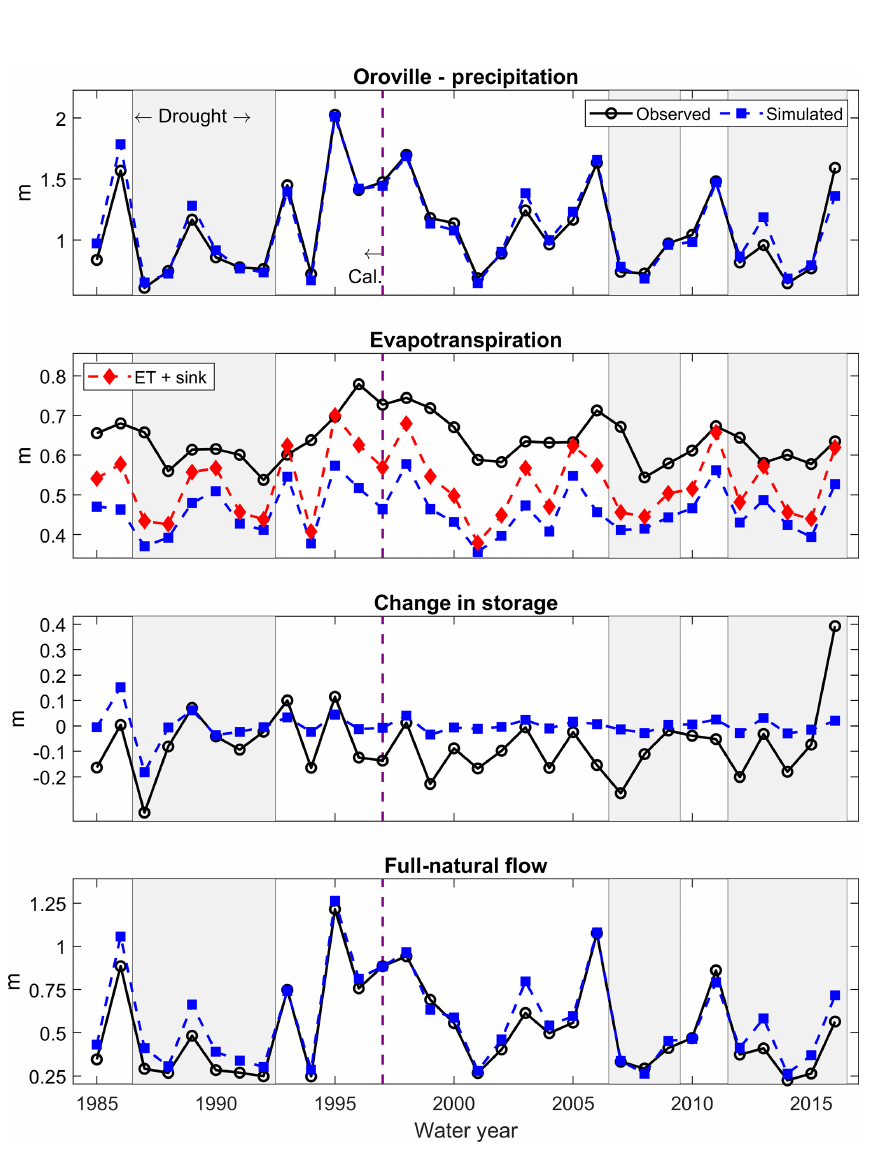
Figure 7. Simulated vs. observed annual basin-wide water-balance components ( P , ET, (cid:49)S , and Q ) for the Feather River at Oroville.